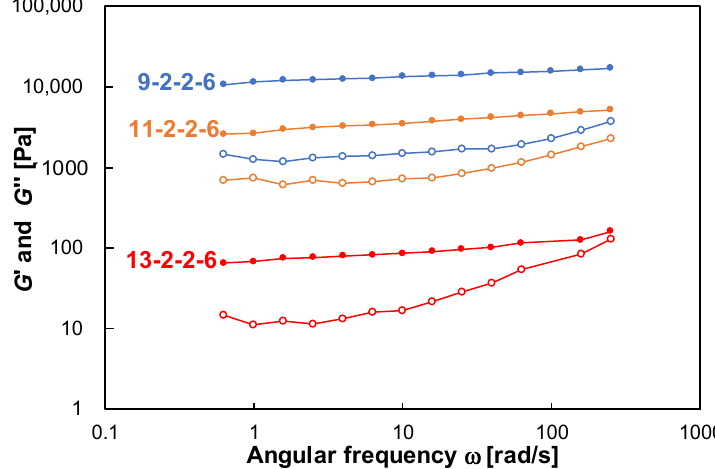
Figure 8. Angular frequency dependence of G ′ (solid circles) and G ″ (open circles) of the k -2-2-6 ( k = 9, 11, and 13) aqueous solutions at 25 °C.